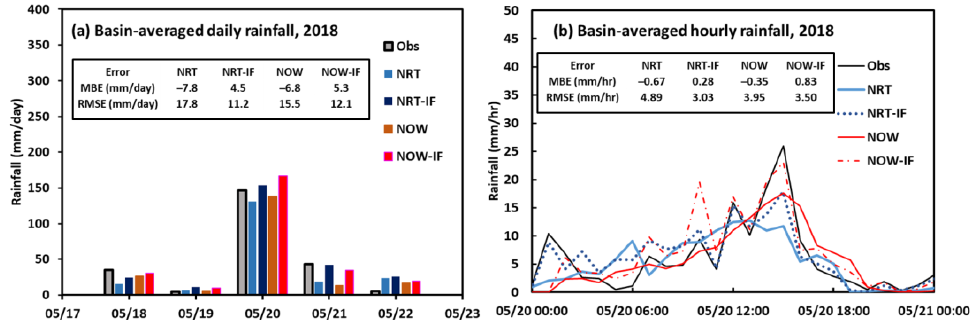
Figure 7. Same as Figure 6 but for May 2018 event: ( a ) daily rainfall (mm/day) and ( b ) hourly rainfall (mm/h).